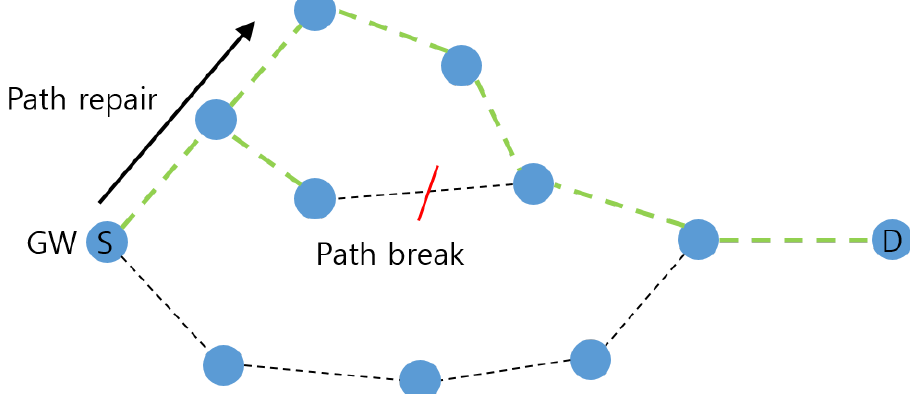
Figure 7. Path repair process with the proposed routing